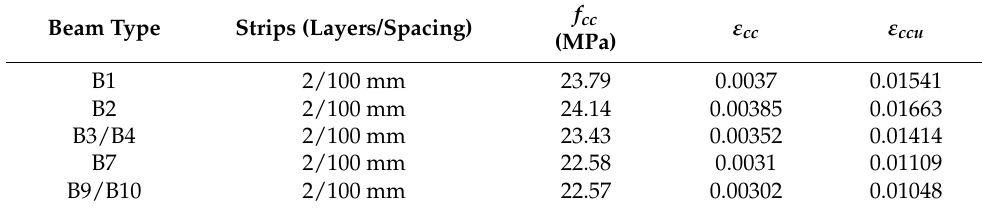
Table 2. Mechanical parameters of confined